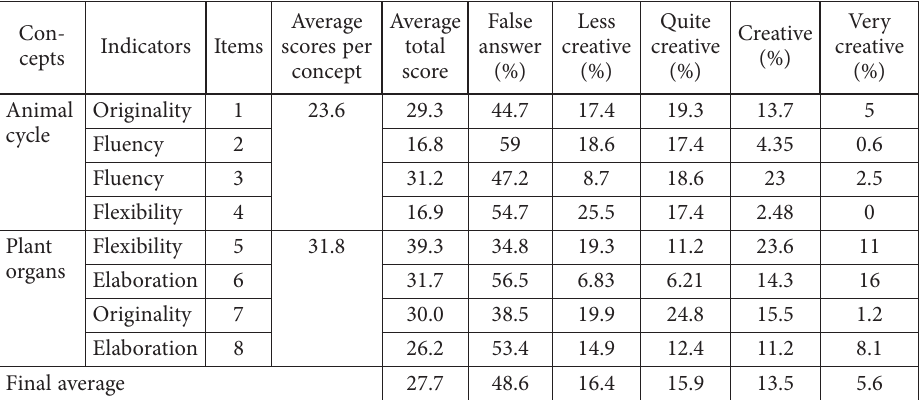
Table 3. Distribution of creative thinking skills levels for elementary students on science concepts (source: created by authors) Con- Indicators Items cepts Animal cycle